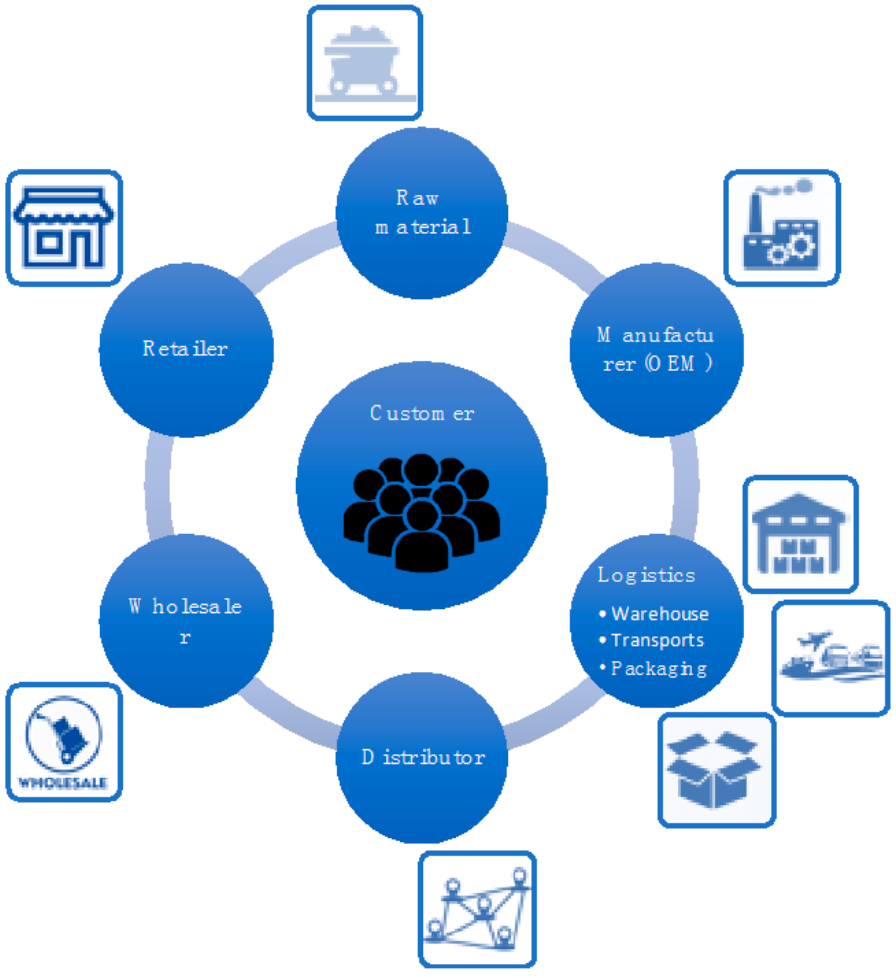
Figure 2. Key actors and activities included in supply chain